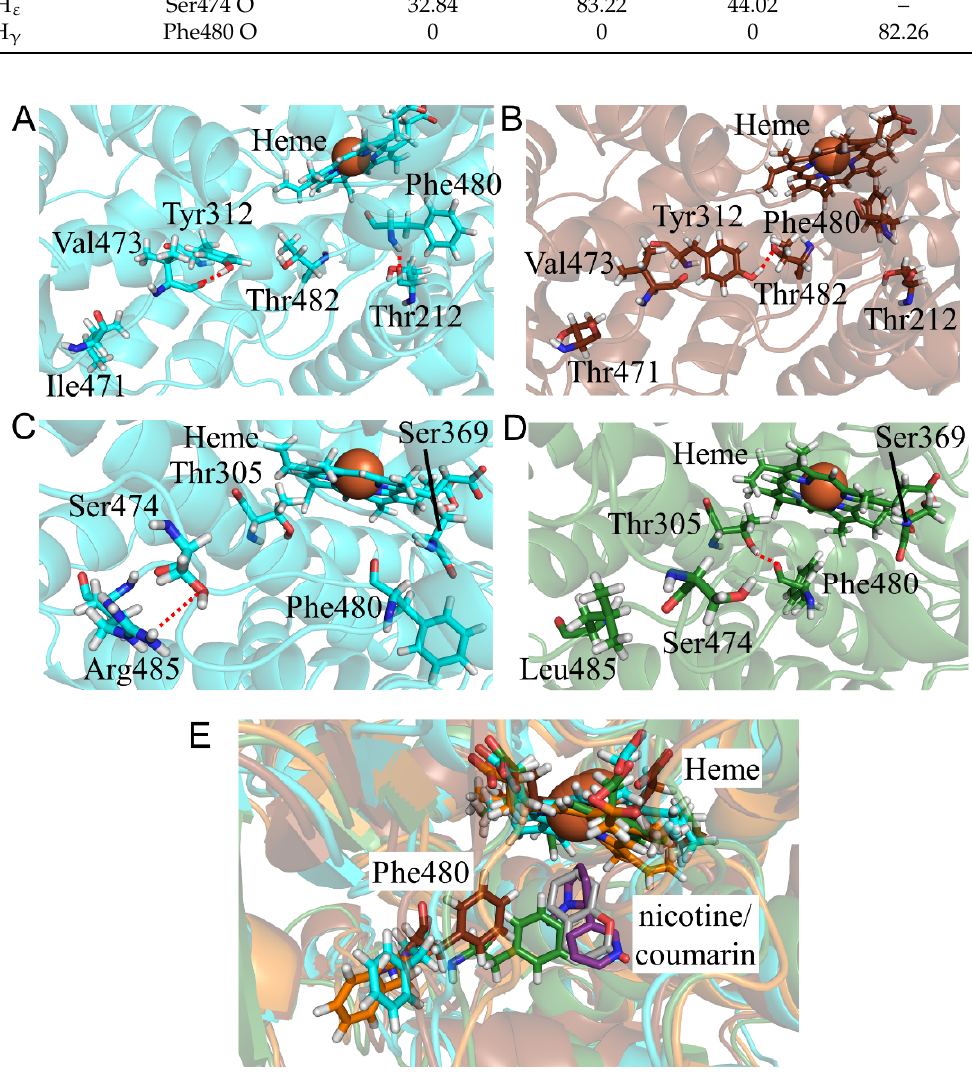
Figure 10. Structural change in CYP2A6.36 and CYP2A6.37 ( A – E ). The wild type, CYP2A6.36, and CYP2A6.37 are shown in cyan, deep green and brawn, respectively. Nicotine and coumarin are illustrated in gray and purple, respectively. Nitrogen, oxygen, and hydrogen are displayed in blue, red, and white, respectively, in the stick model. Iron is shown as an orange sphere by a model written as van der Waals radius. The red dotted lines indicate the hydrogen bonds.